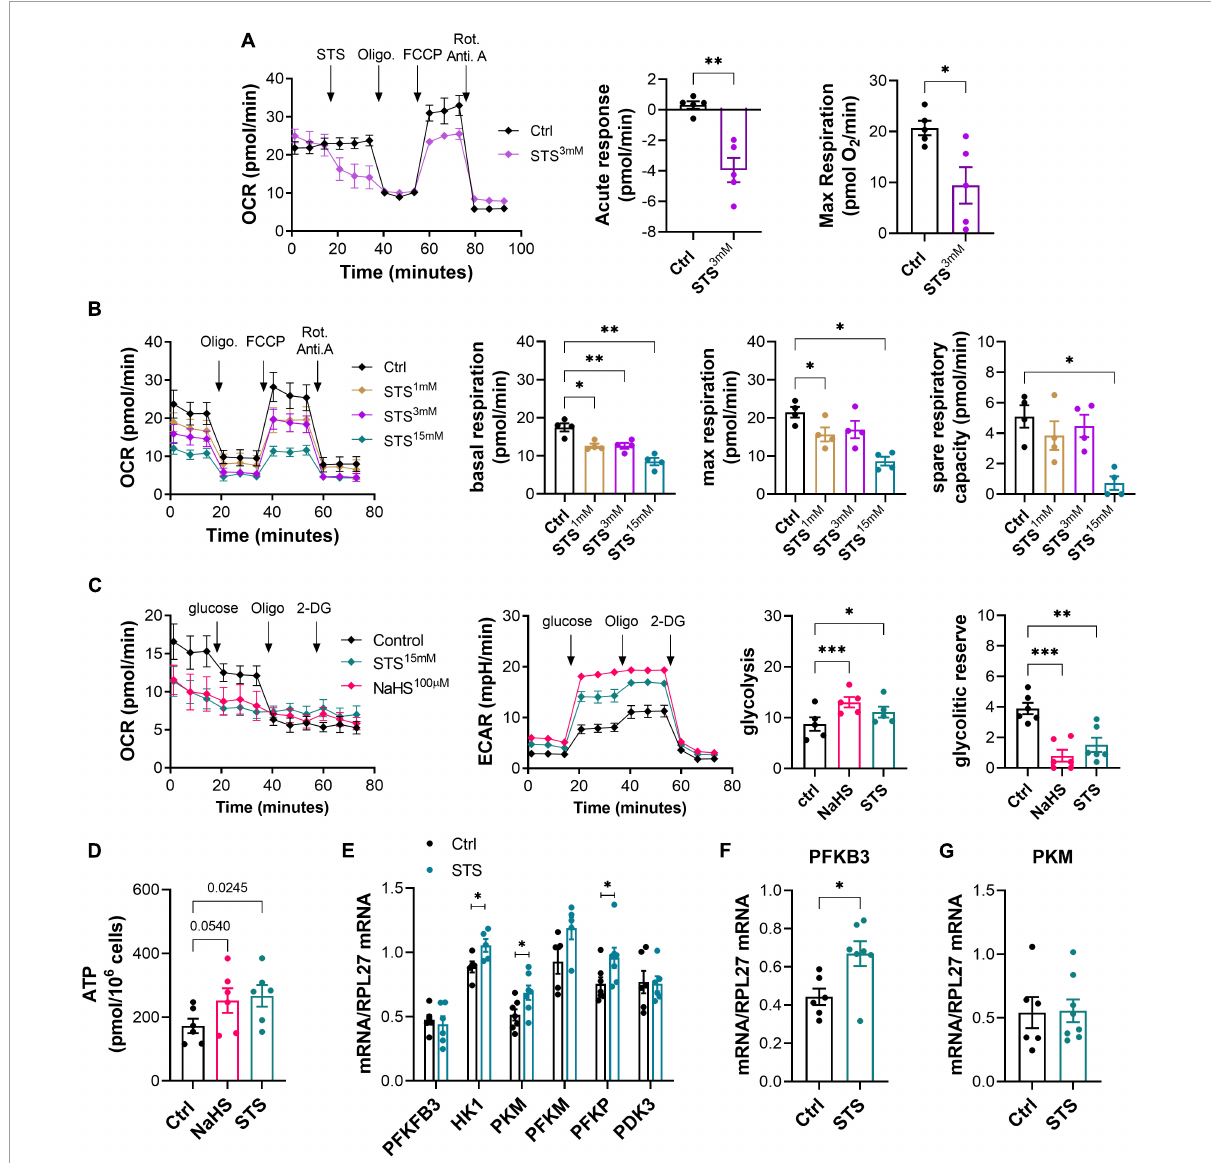
FIGURE5 Sodium thiosulfate (STS) inhibits mitochondrial respiration and increases glycolysis and adenosine triphosphate (ATP) production in HUVECs. (A) Acute effect of STS on respiration in a mitochondrial stress test assay using HUVEC. Left panel: representative traces of oxygen consumption rate (OCR). Right panels: quantitative assessment of decreased OCR in response to STS injection and maximal respiration upon FCCP injection. Data are mean ± SEM of five independent experiments. * p < 0.05, ** p < 0.01 as determined by bilateral unpaired t -test. (B) Mitochondrial stress test in HUVEC pre-treated for 4 h with increasing concentration of STS, as indicated. Data are mean ± SEM of 54 independent experiments. * p < 0.05, ** p < 0.01 as determined by repeated measures mixed-effects model (REML) followed by Dunnett’s multiple comparisons tests. (C) Glycolysis stress test in HUVECs pre-treated for 4 h with 3 mM STS or 100 µ M NaHS. Glycolysis is measured by extracellular acidification rate (ECAR). Data expressed as mean ± SEM of five independent experiments. * p < 0.05, ** p < 0.01, *** p < 0.001 as determined by repeated measures mixed-effects model (REML) followed by Dunnett’s multiple comparisons tests. (D) Adenosine triphosphate (ATP) production in HUVEC treated for 24 h with 100 µ M NaHS or 3 mM STS. Statistics are p -values determined by bilateral unpaired t -test. (E) Normalized mRNA levels of key glycolysis genes in HUVEC pre-treated for 4 h with 15 mM STS. Data are mean ± SEM of seven independent experiments. * p < 0.05 as determined by bilateral unpaired t -test. (F,G) PFKFB3 (F) and PKM (G) mRNA levels in the gastrocnemius muscles of mice treated or not